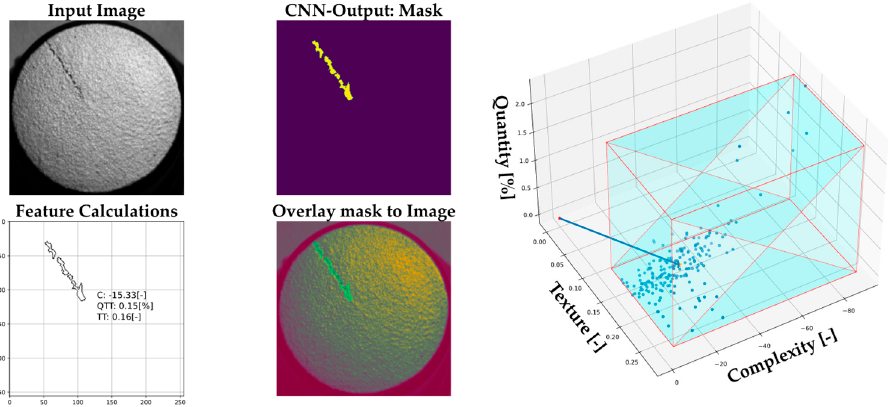
Figure 7. Confusion matrix (validation data), results of the training process.